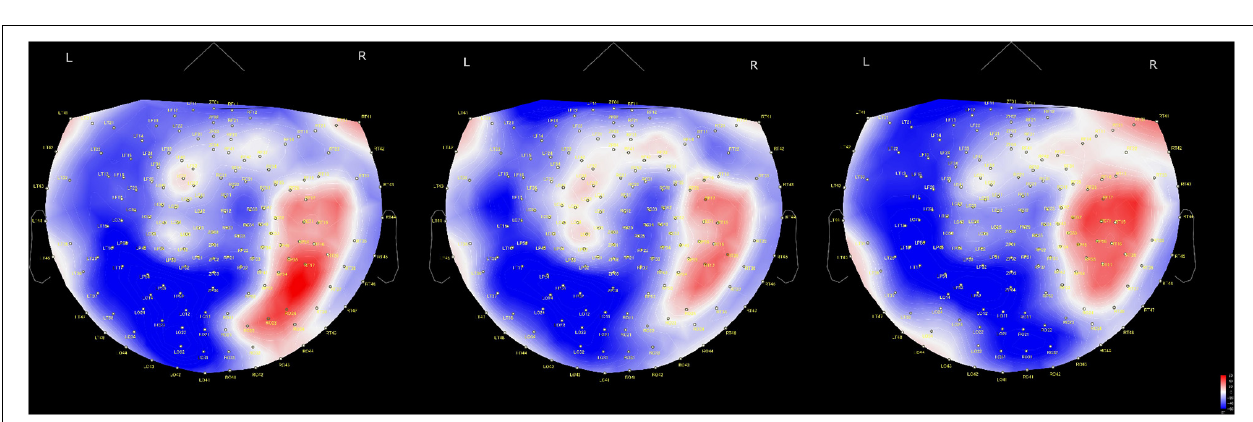
FIGURE 4 | Time-dependent changes in activated brain areas on 2D cap images. Time windows: left shows 62–140 ms, middle shows 122–180 ms and right shows 182–304 ms. L, left hemisphere; R, right hemisphere. The color bar denotes amplitude (fT) from –60 (blue) to 60 (red).